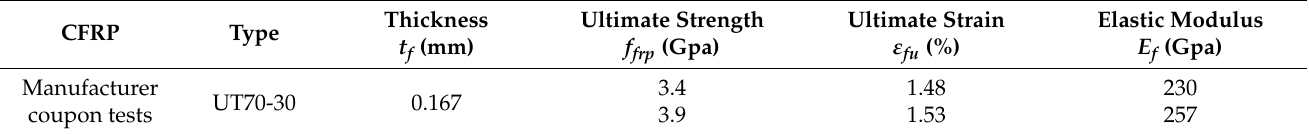
Table 6. Mechanical properties of CFRP.